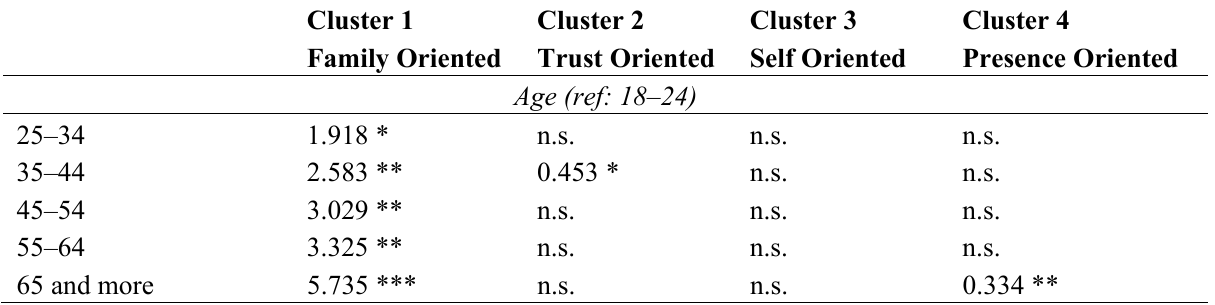
Table 2. Predictors of belonging to type of friendship representations: logistic regressions (odds